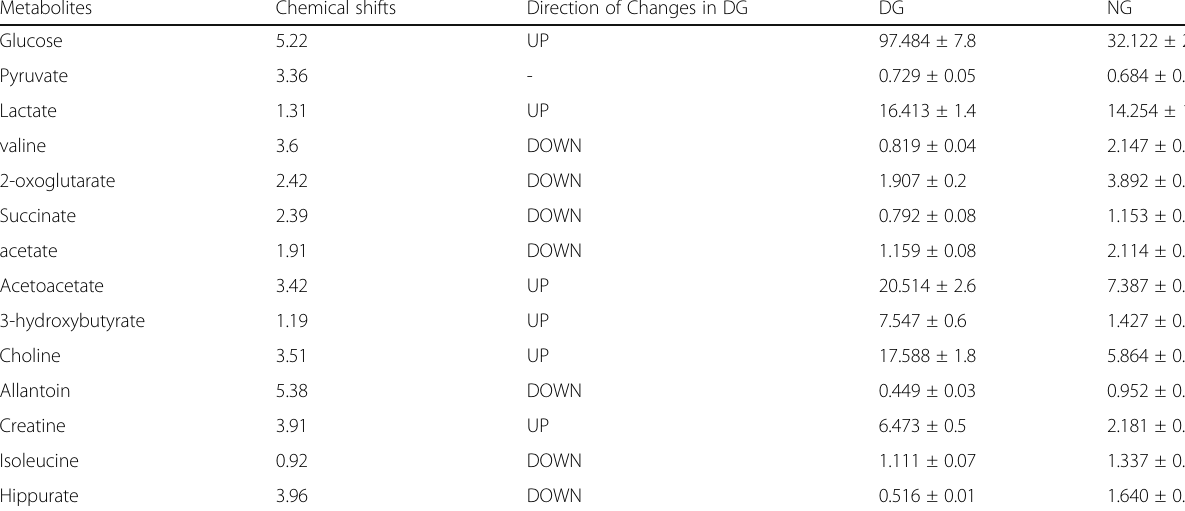
Table 3 Relative quantitative (mM) of discriminating metabolites of serum in obese diabetic rats (DG) and normal diet rats (NG) before treatment using Chenomx NMR Suite Metabolites Chemical